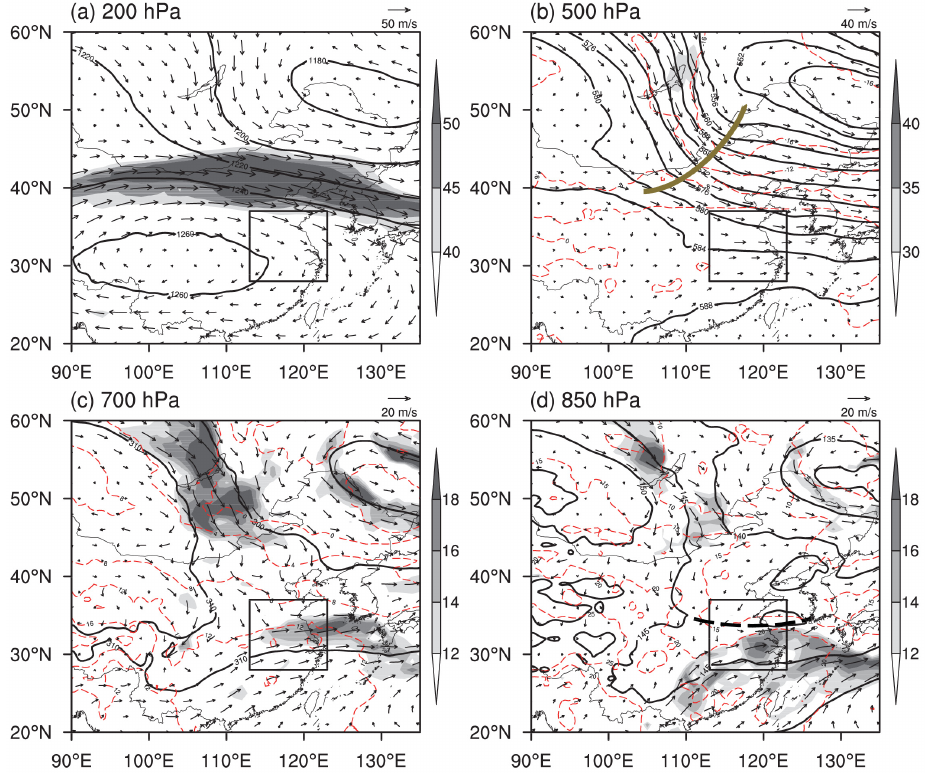
Figure 3. Geopotential heights (black solid line), temperature (red dotted line), and wind field (arrow: wind direction; shadow: full wind speed) at 0000 UTC on 30 June 2015 at the level of ( a ) 200 hPa; ( b ) 500 hPa; ( c ) 700 hPa and ( d ) 850 hPa. The trough line at 500 hPa (brown line) and the shear line at 850 hPa (black dotted line) are plotted. The black rectangles mark the analysis region shown in Figure 1.